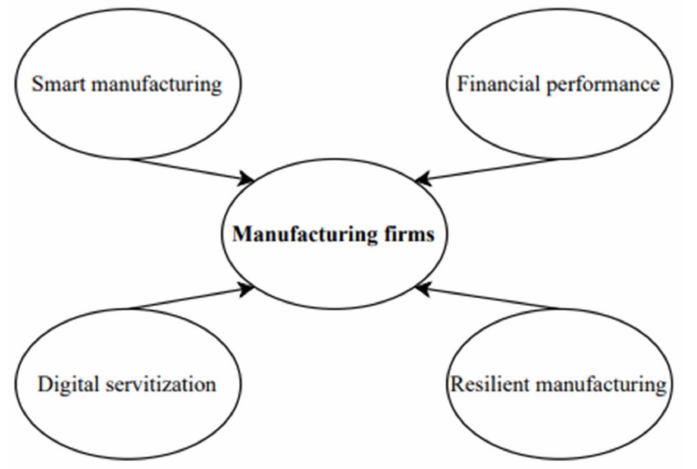
Figure 1. Conceptual